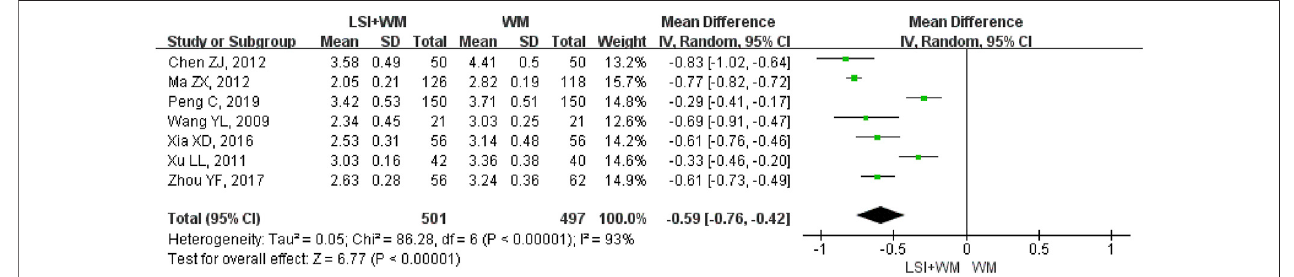
FIGURE 5 | Forest plot of fi brinogen of ligustrazine injection in treating ACI. LSI is ligustrazine injection and WM is Western medicine.